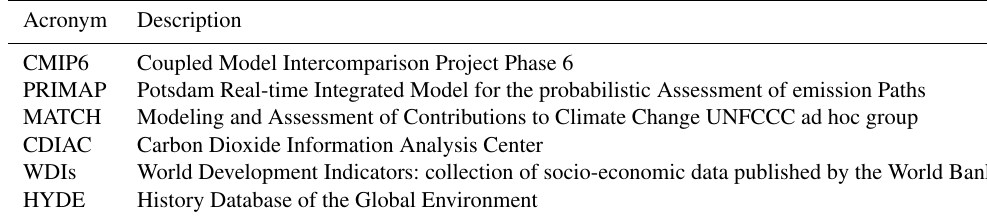
Table A7. Miscellaneous